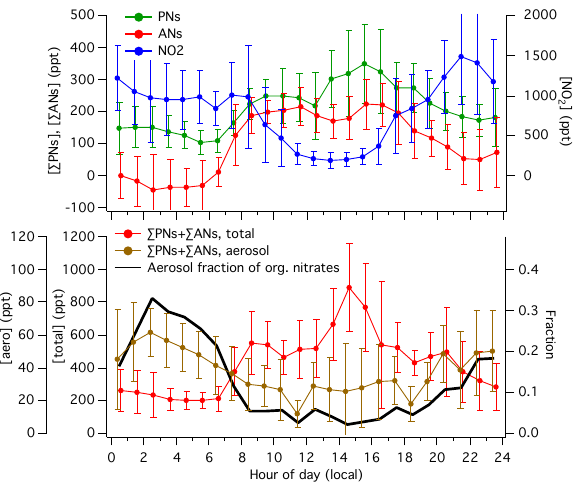
Fig. 5. Hourly binned average diurnal trends in (top): NO 2 (blue), 6 PNs (green), and 6 ANs (red) from times when the TD-LIF was running in “3-gas” mode (13–17 and 19–20 August); and (bot- tom): total 6 PNs + 6 ANs (red), aerosol-phase-only 6 PNs + 6 ANs (brown), and fraction of organic nitrates in the aerosol phase (black) from times when the TD-LIF was running in “gas/aerosol” mode (28 July–1 August, 20–22 August). Error bars are 1 σ based on data averaged to a one-hour timebase; all points are averaged for the same hour intervals but offset slightly on some plots to make er- ror bars easier to read. The NO 2 trace looks slightly different than Fig. 3 because this data comes only from the subset of campaign days when the TD-LIF was running in “3-gas” ambient